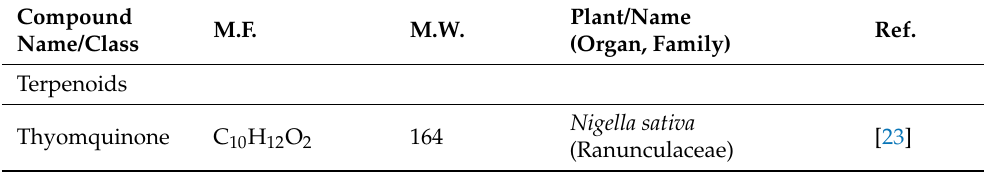
Table 1. List of natural compounds evaluated for protective effects against CA-induced renal injury.